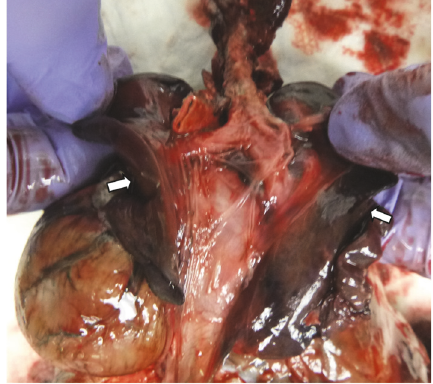
Figure 4: Figure shows hypoplastic lung